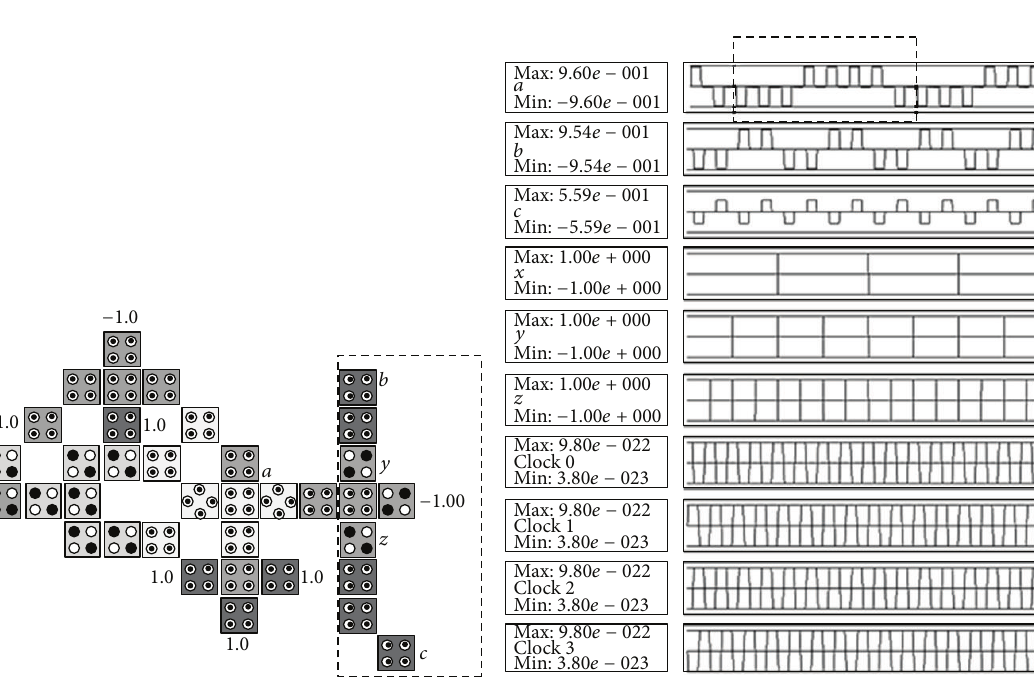
Figure 12: The Toffoli gate: (a) truth table, (b) reversible circuit representation.